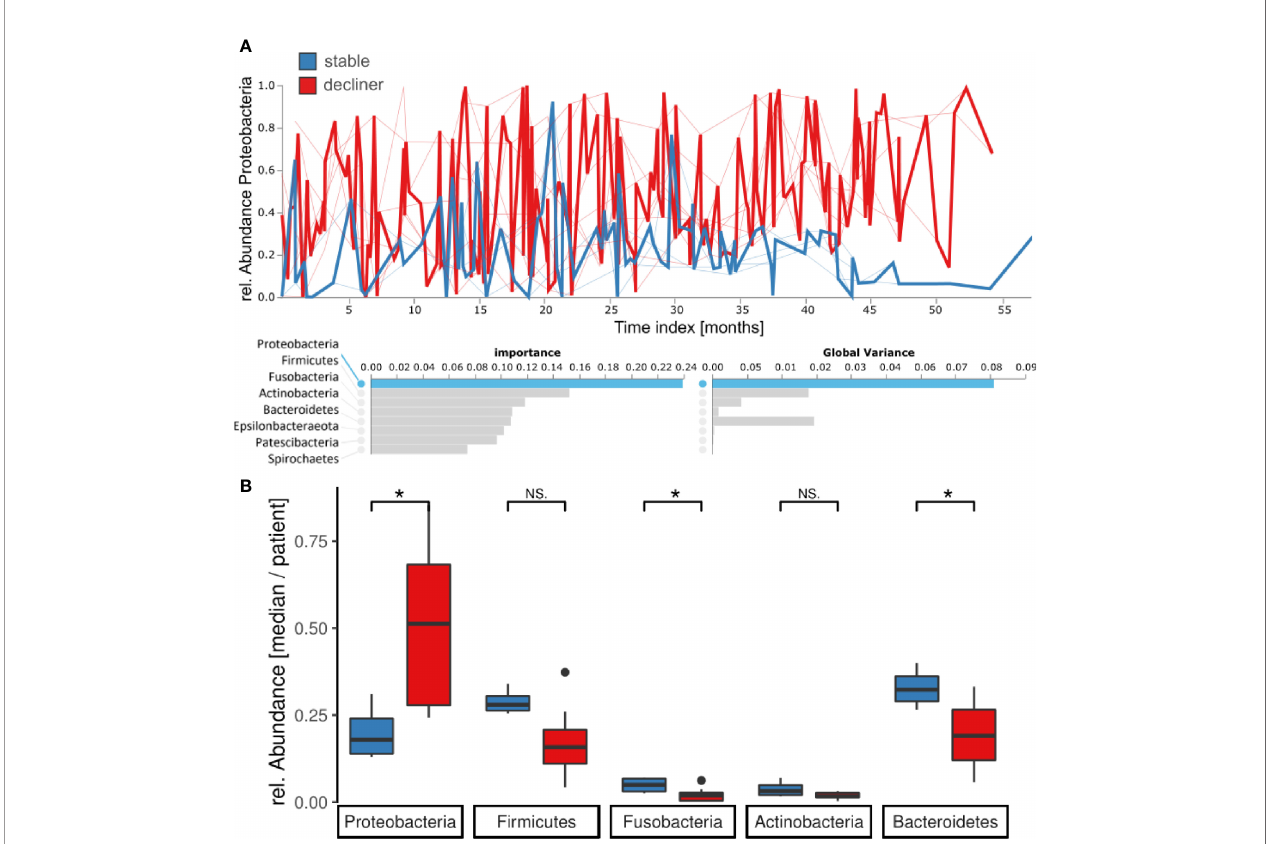
FIGURE 4 | Proteobacteria are enriched for patients in the decliner group. (A) Longitudinal feature volatility analysis at the phylum level reveals the Proteobacteria as the most important feature for the microbiome progression in this study. (B) Median relative abundance for each patient of the fi ve most important phyla grouped by the patient groups. *p < 0.05, NS, not signi fi